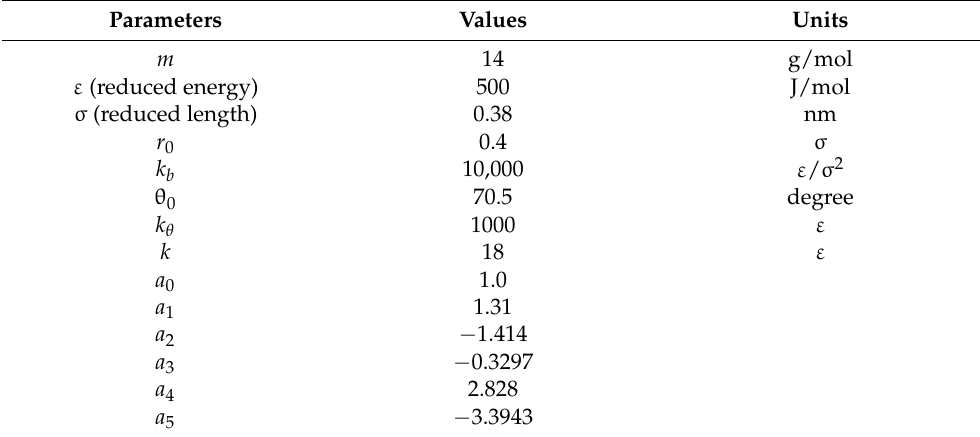
Table 1. Values of the parameters used in the simulation. Parameters Values Units m 14